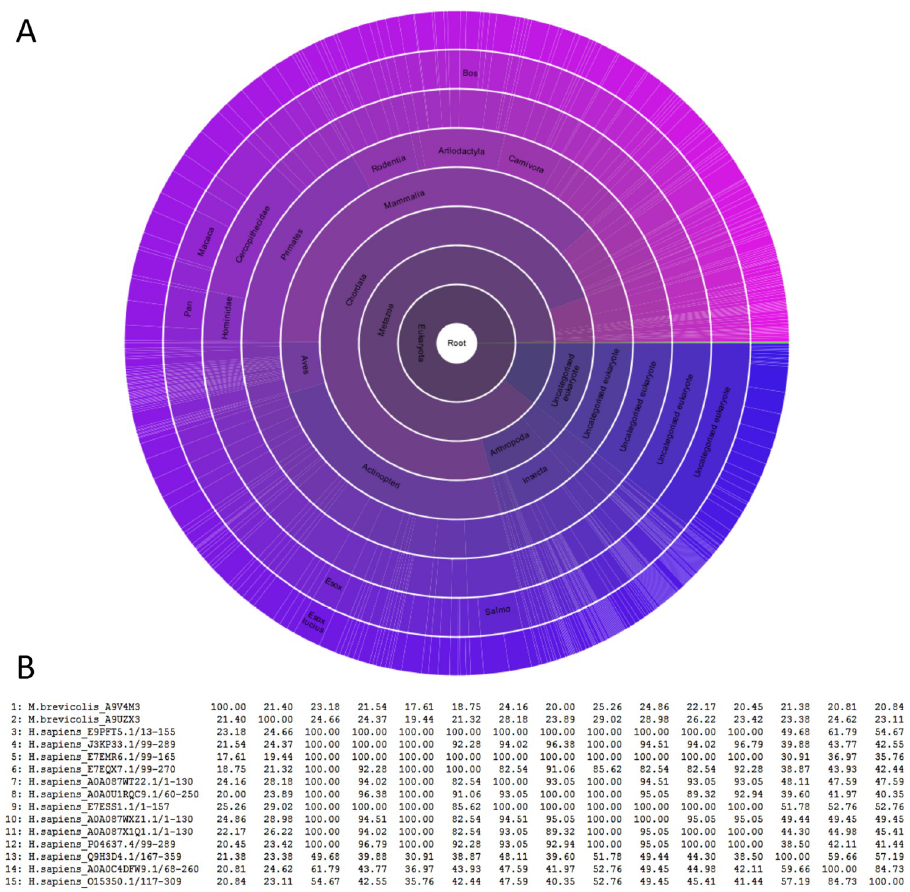
Fig 2. Sunburst plot of the distribution of the p53 protein domain (PF00870) in living organisms according to Pfam (accessed September 06, 2021). The plot shows the distribution of the 1,765 sequences containing the P53 binding domain across 382 species. Every bar on the periphery represents one single species, containing one or several p53 paralogues in their genome ( A ), and percent identity matrix created by CLUSTALW 2.1 of the 7 human p53 domain-containing proteins and two of their most distant homologues from the choanoflagellate Monosiga brevicollis ( B ). amino acids. According to Pfam 35.0 [27], HsTP53 contains four main protein domains: P53 TAD (transactivating domain), TAD2, P53 DNA binding domain, and P53 tetramer. P63 and p73 also contain the P53 DNA binding domain and the P53 tetramer domain. The P53 TAD and TAD2 domains are absent in P63 and P73, but instead both include a single SAM_2 domain. P53 (PF00870 in Pfam) is the main domain of the p53 protein, covering the amino acids 99 to 289. Pfam contains 1765 P53-domain-containing sequences from 382 species, all in choano- organisms (metazoans and choanoflagellates), including 5 sequences in choanoflagellates and 13 sequences in the genome of Homo sapiens ( Fig 2A , the figure can also be accessed here: